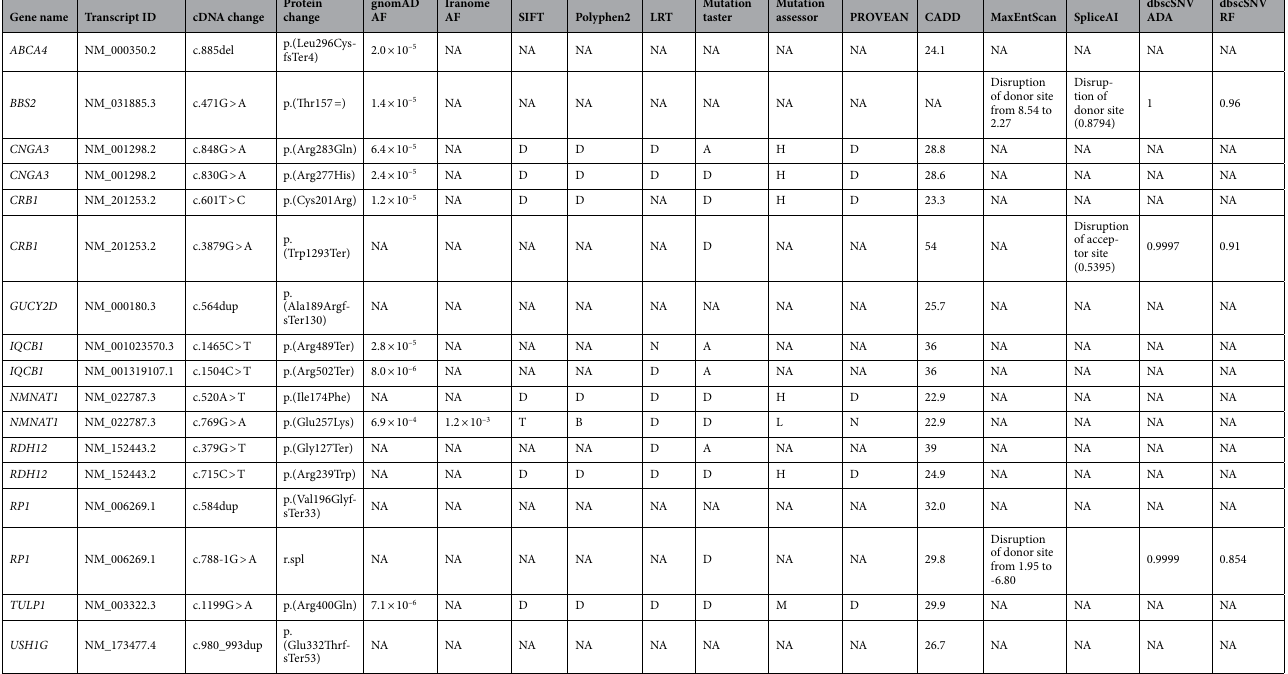
Table 3. Allele frequencies and pathogenicity scores for all variants identified. AF allele frequency, D deleterious (SIFT, LRT, PROVEAN) or disease_causing (mutation taster) or damaging (Polyphen 2), B